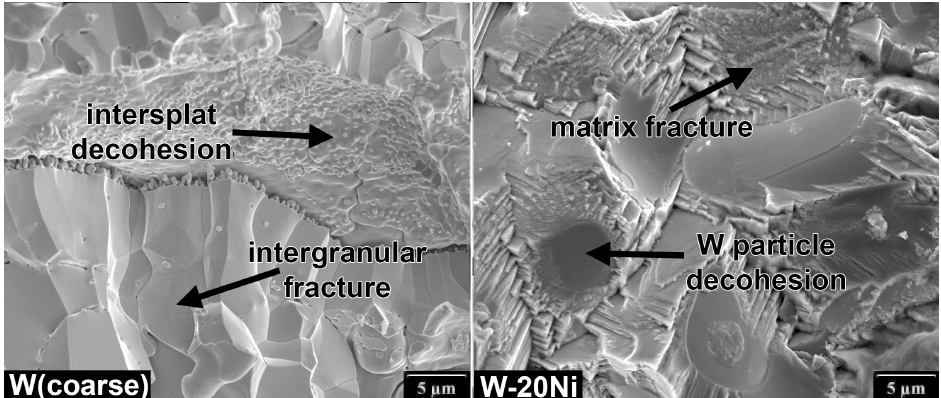
Figure 7. Fracture surfaces of W (coarse) deposit with the worst fracture properties and fracture surface of the W-20Ni WHA with the best fracture properties among all RF-sprayed materials (see Figure 6). Table 3. Mechanical properties of the materials in tension (elastic modulus E t , yield strength R p02t , tensile strength R m , and ductility A 5) as well as fracture mechanical properties of the investigated refractory RF-ICP deposits and two powder metallurgy